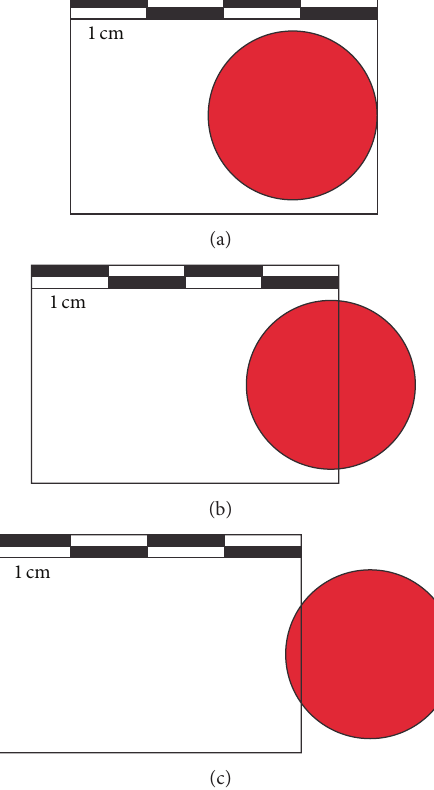
Figure 7: Edge effect in the targets, using the Ilris 3D divergence (2,2 cm at 100m) and 1cm space between the points. (a) The laser pulse in full incidence on the target. (b) The laser pulse with almost 50% incidence on the target, obtaining a second response from part of the pulse outside the target. (c) The laser pulse with only 10% of incidenceinthetarget,obtaininganextremelylowintensityprimary point and a stronger second